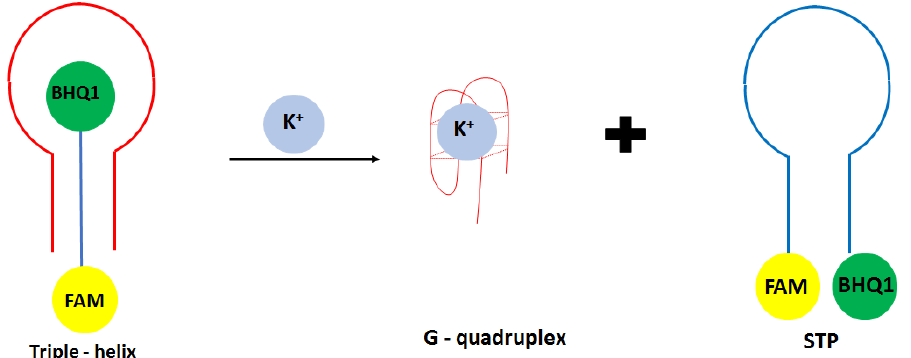
Figure 4. The sensing principle scheme of the fluorescence aptasensor for potassium ion with the use of triple—helix structure.